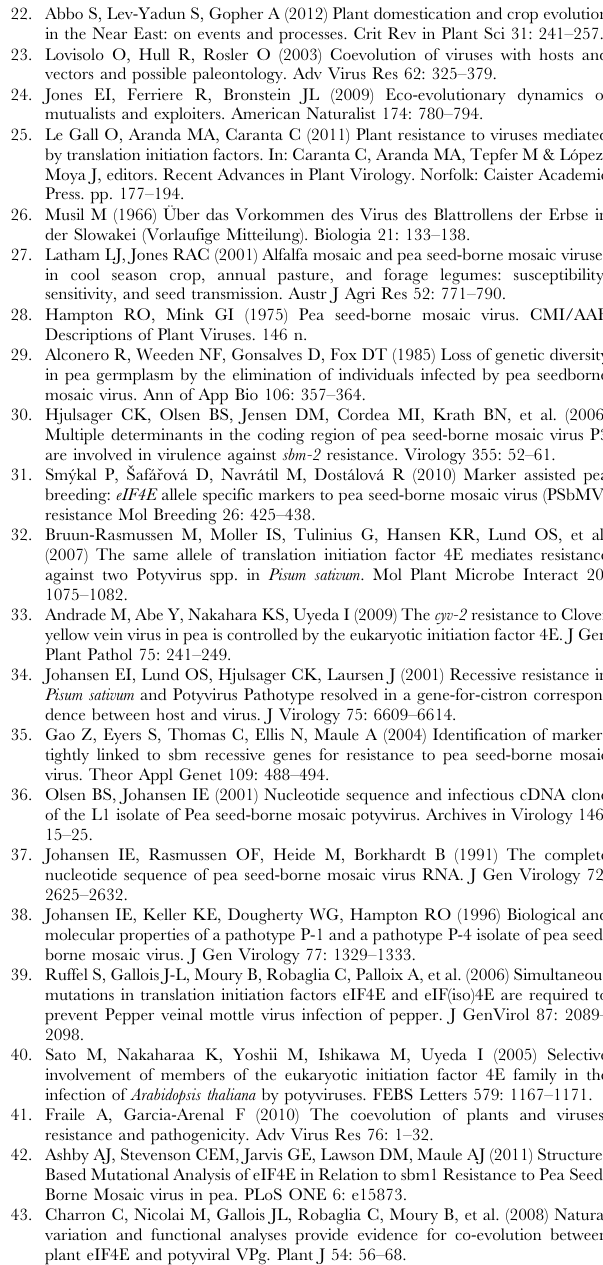
are indicated as positive, susceptible (S) and resistant (R) reactions, respectively.